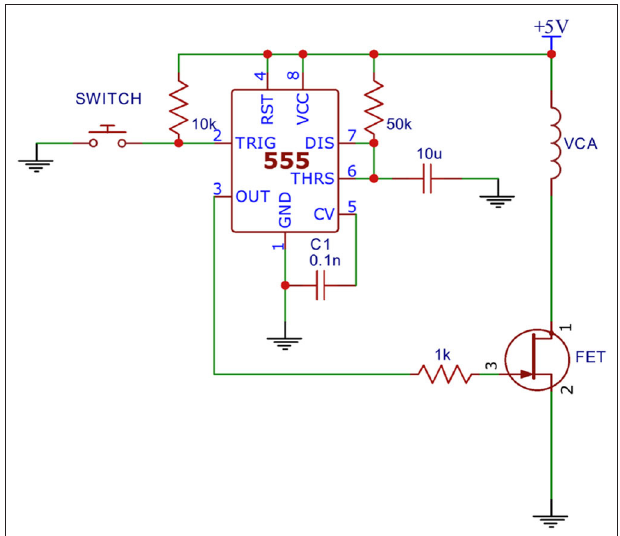
FIGURE 2 | Dedicated mechanical